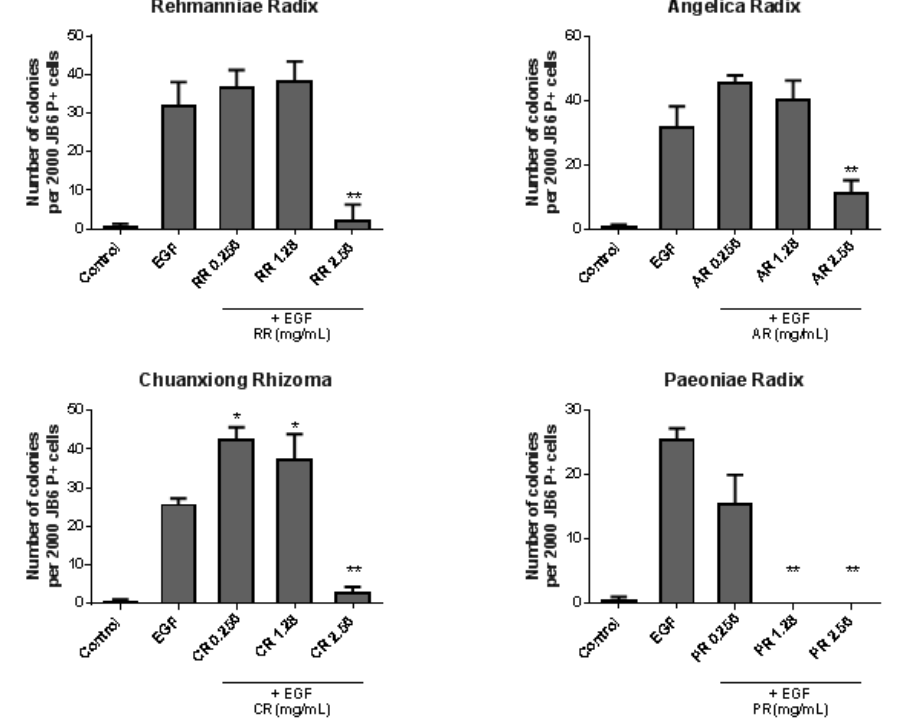
Figure 2. Effects of four single herbal components of SWT on EGF-induced malignant transformation of JB6 P+ cells. Soft agar assay was conducted on JB6 P+ cells treated with EGF (10 ng/mL) and/or SWT herbal components at three concentrations. Colonies greater than ten cells were counted manually under a microscope. Data represents a mean ± standard deviation ( n = 6-12). *: p < 0.05; **: p < 0.01, compared to EGF only group.